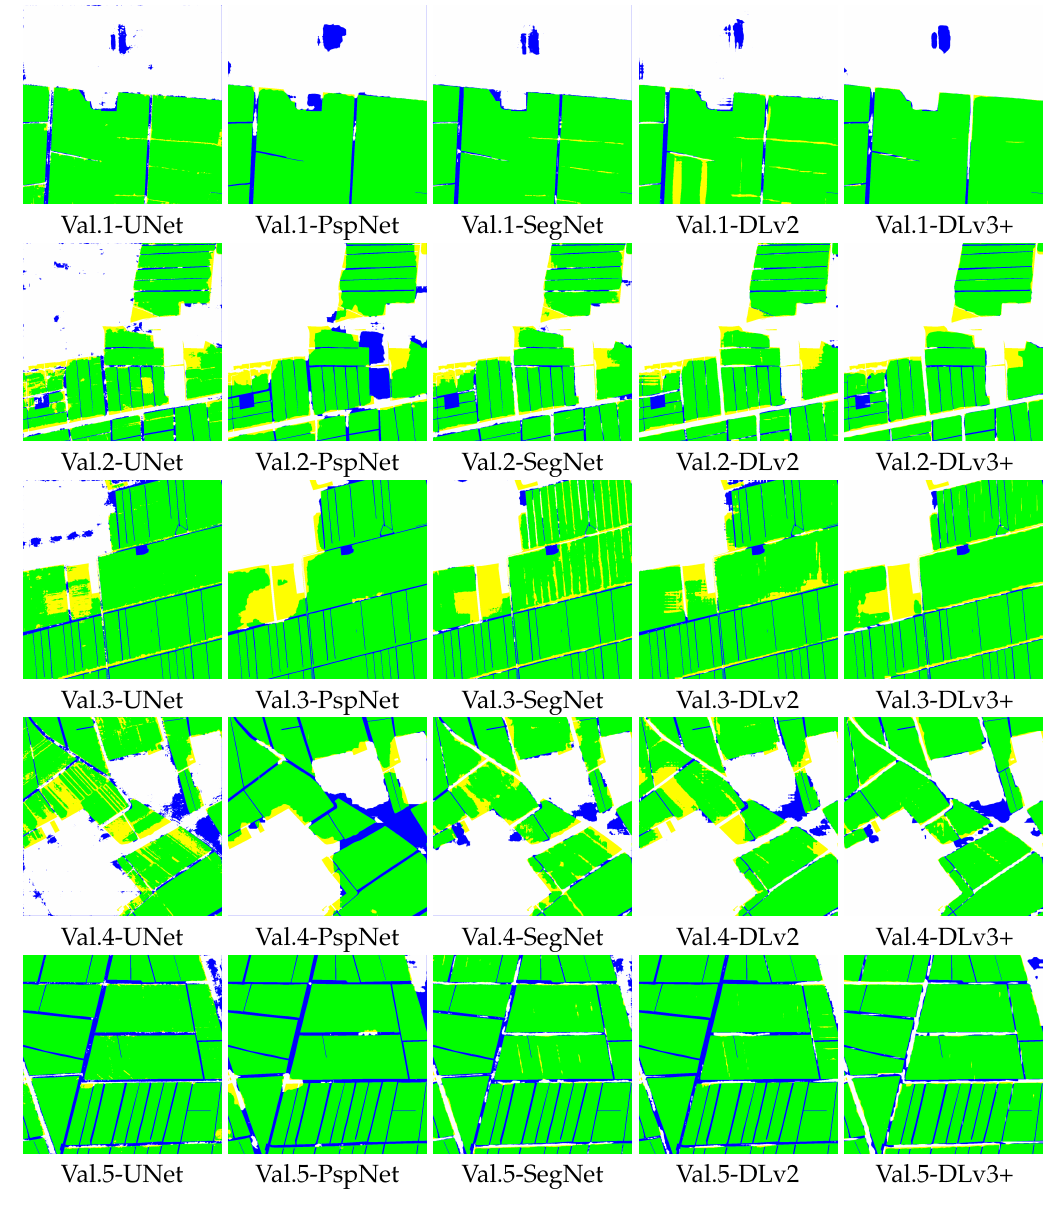
Figure 6. Cont . Figure 6.